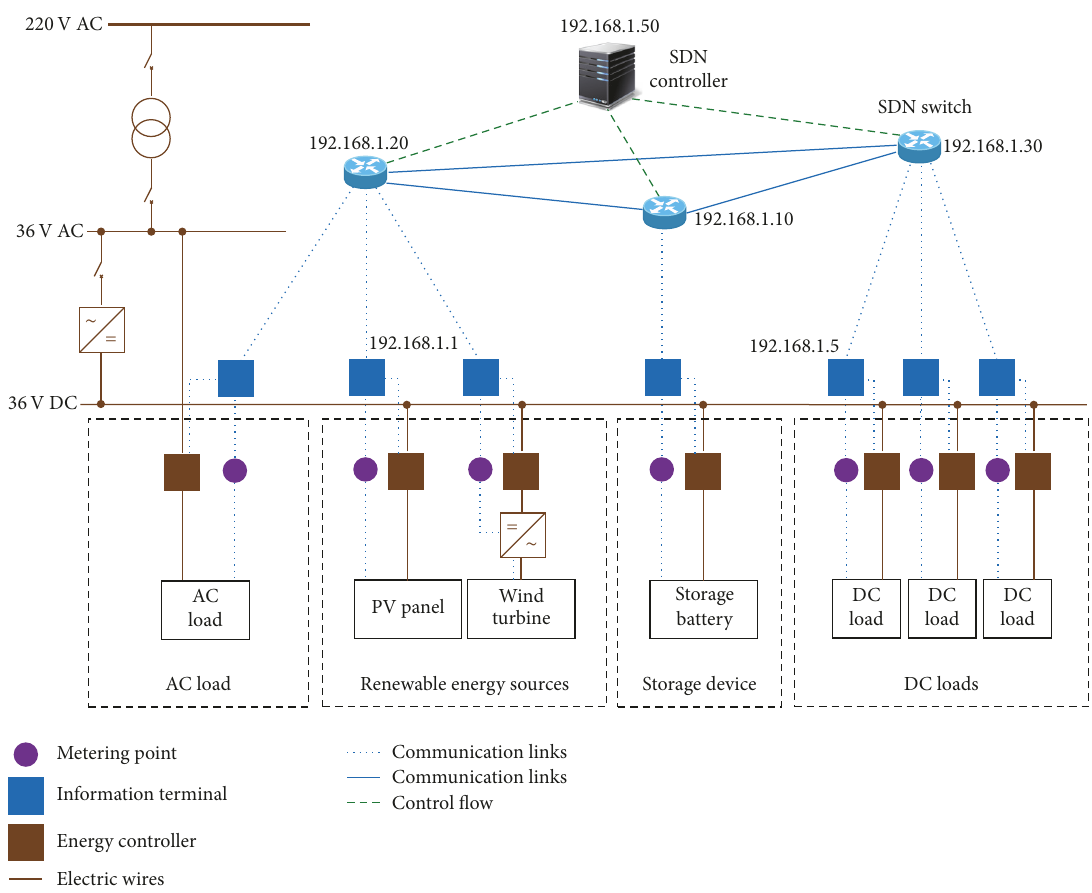
Figure 8: Implementation of testbed for communication network of microgrid.